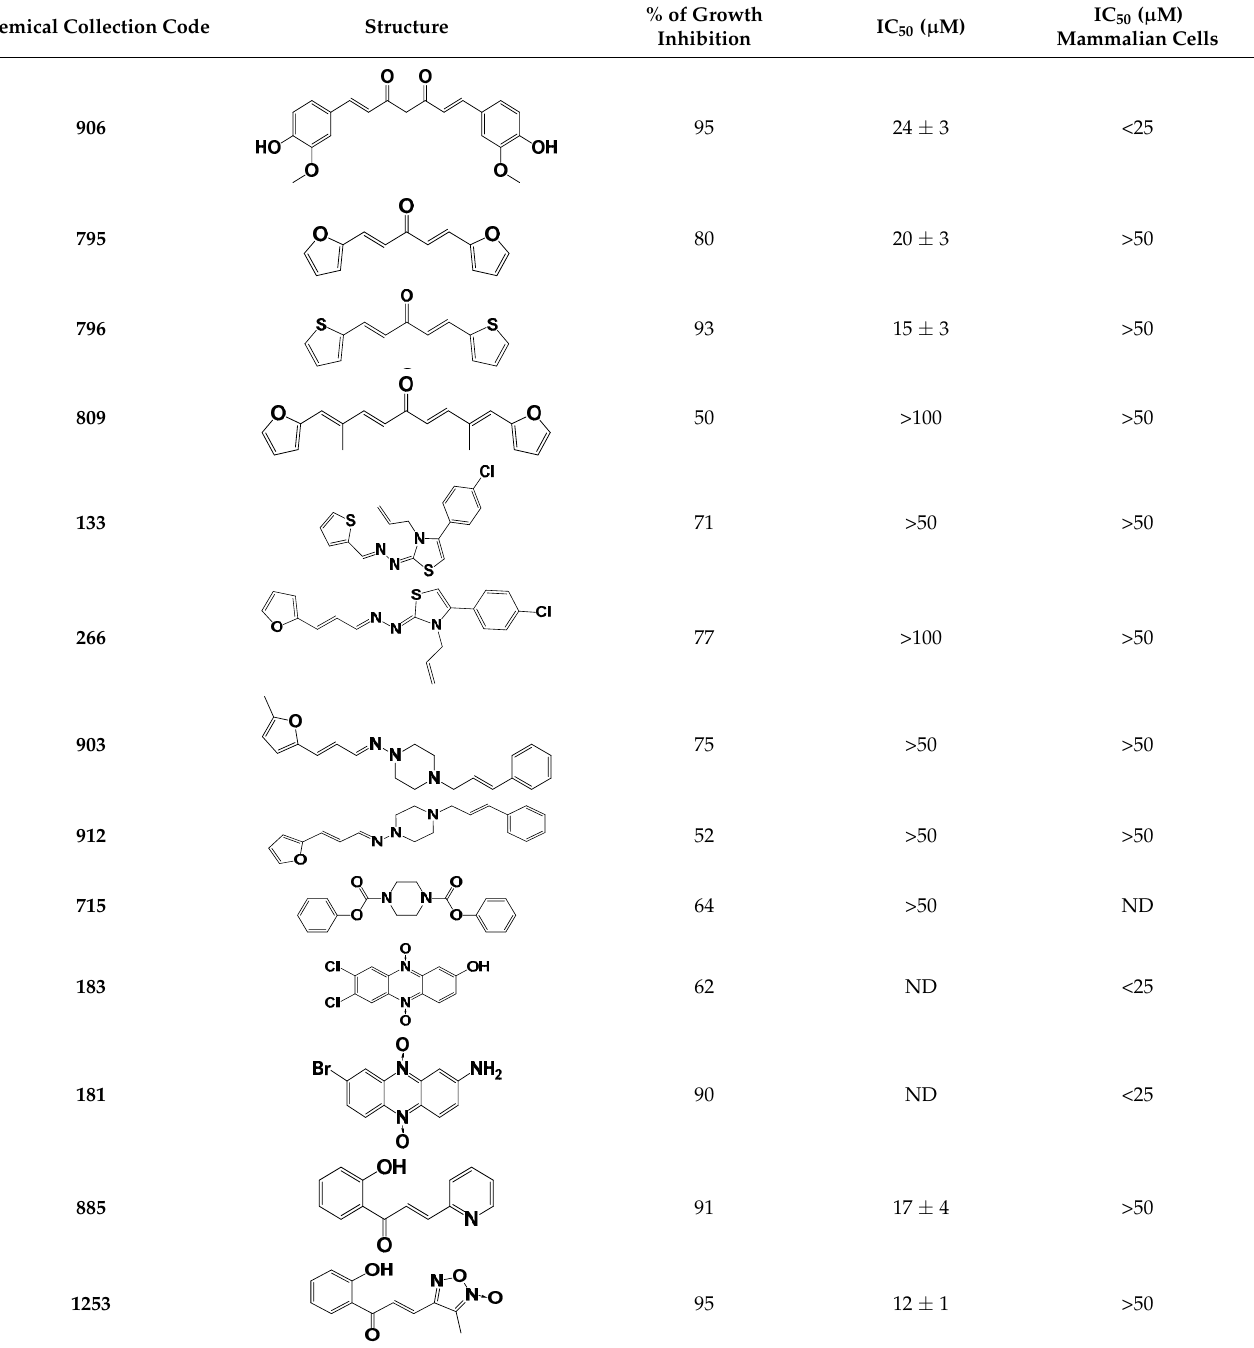
Table 2. Phenotypic screening of synthetic compounds at a concentration of 100 µM using the em- bryonic cell line BME26 from R. microplus.